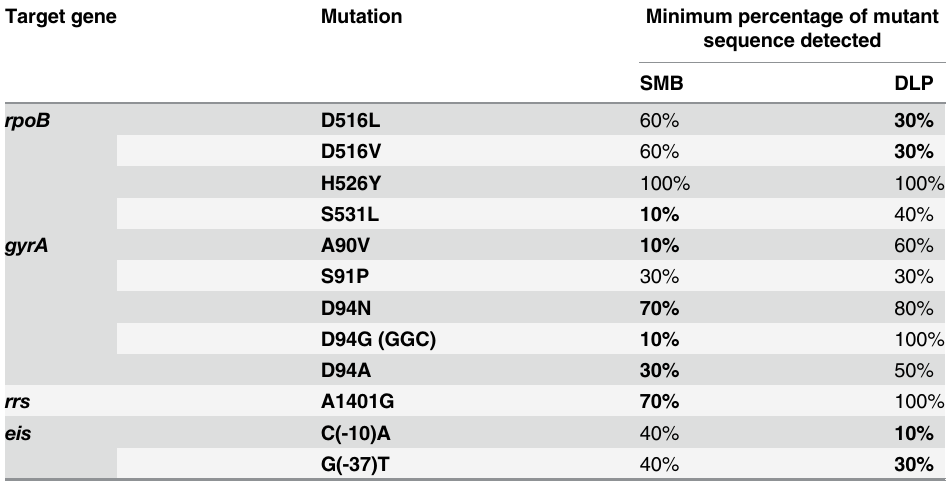
Minimum percentages of the mutant detected by an individual assay as compared to the other are shown in